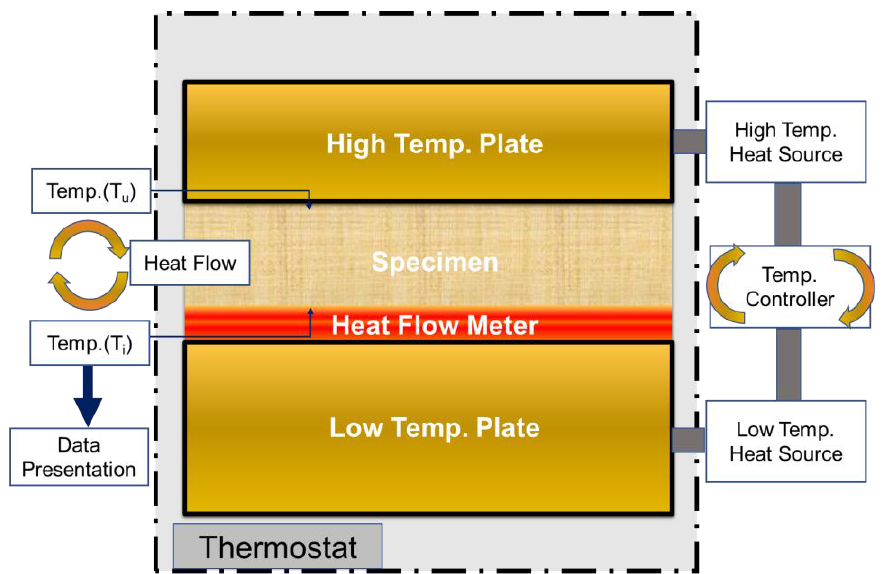
Figure 2. Outline of the thermal conductivity test method using a heat flow meter.